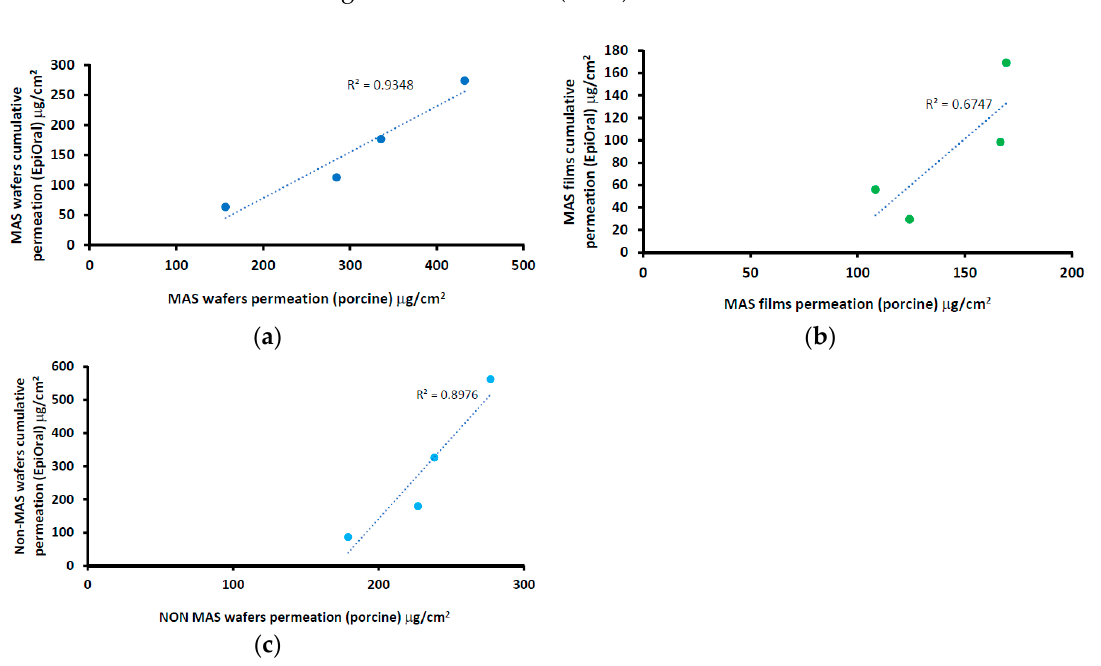
Figure 10. Correlation between porcine and EpiOral TM cumulative permeation curve for ( a ) MAS wafers, ( b ) MAS films, and ( c ) non-MAS wafers.